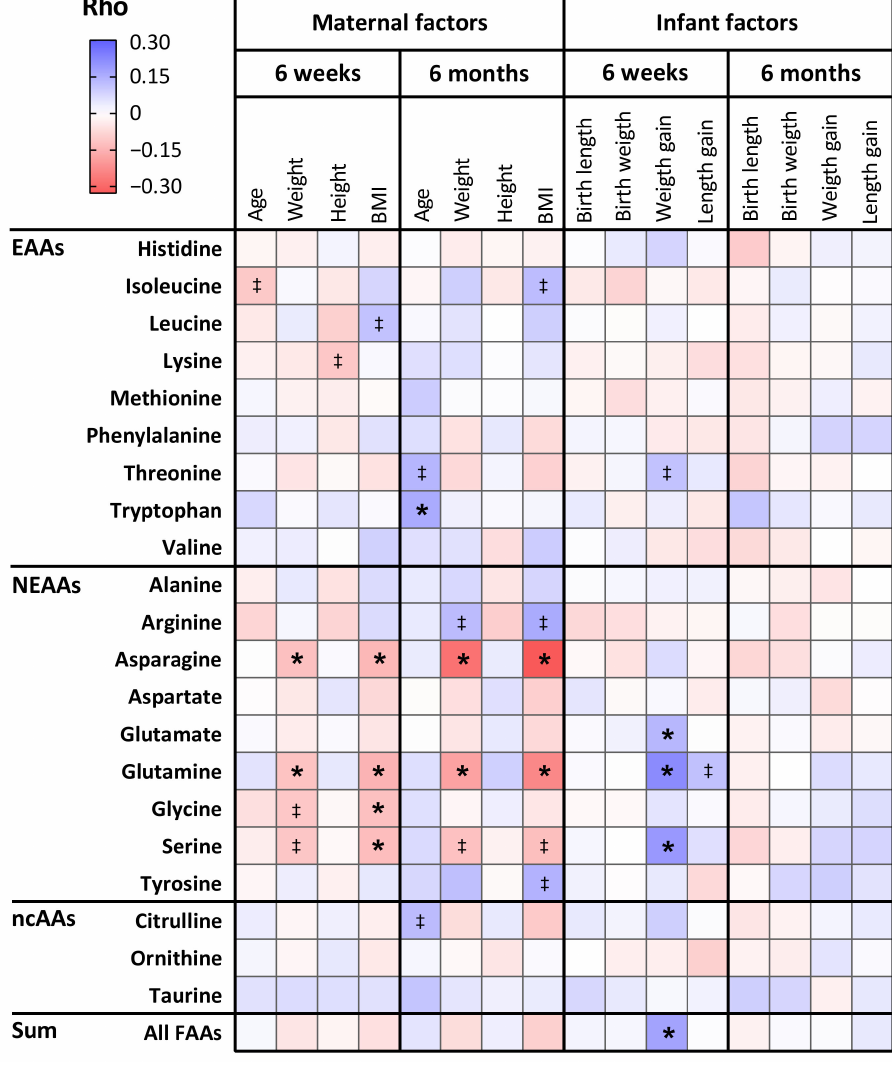
Figure 3. Heatmap of correlations of free amino acids (FAAs) in human milk with maternal and infant anthropometric measurements. Colouring reflects direction and magnitude of the Spearman corre- lation coefficients. EAA: essential amino acid; NEAA: non-essential amino acid; ncAA: non-coded amino acid; BMI: body mass index. ‡ p < 0.01, * p -value remains statistically significant following Bonferroni adjustment. Bonferroni-adjusted level of statistical significance is α = 0.05/22 = 0.002. Maternal pre-pregnancy weight and BMI were positively correlated with the sum of TAAs ( r = 0.145 and r = 0.143, respectively; p ≤ 0.003) and with most individual